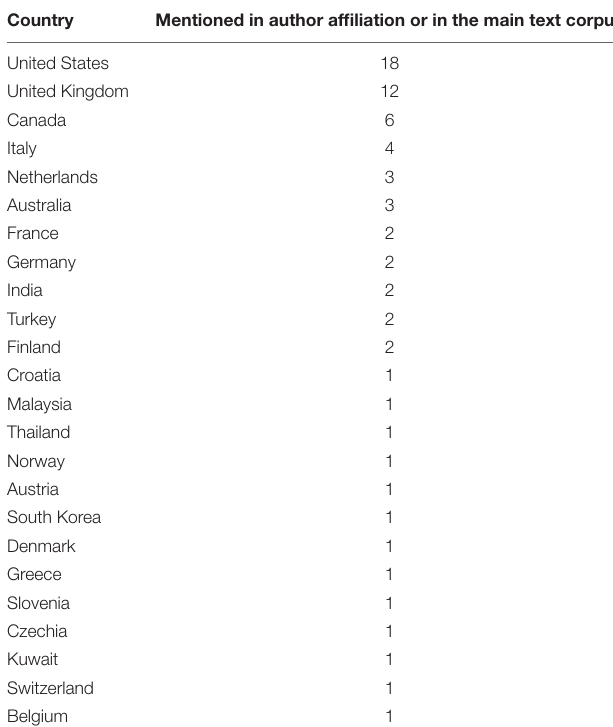
TABLE 1 | Countries mentioned in author affiliations for different articles (main